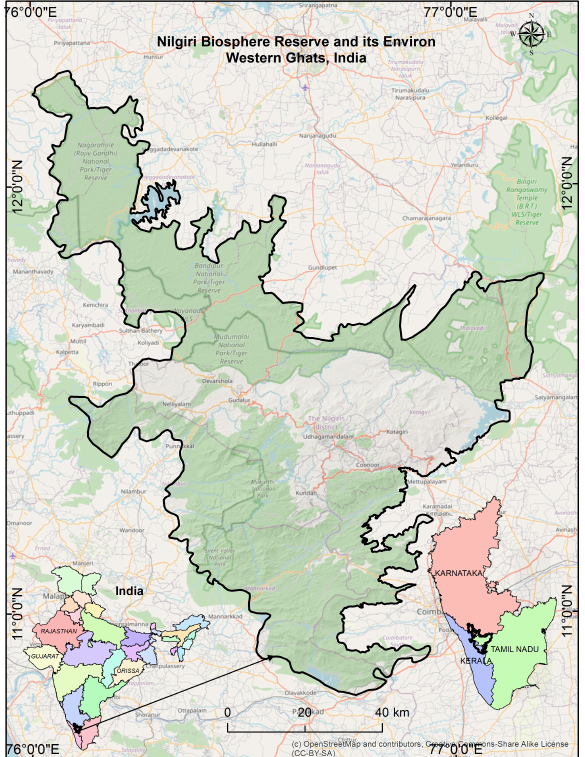
Figure 1. Study Area: Nilgiri Biosphere